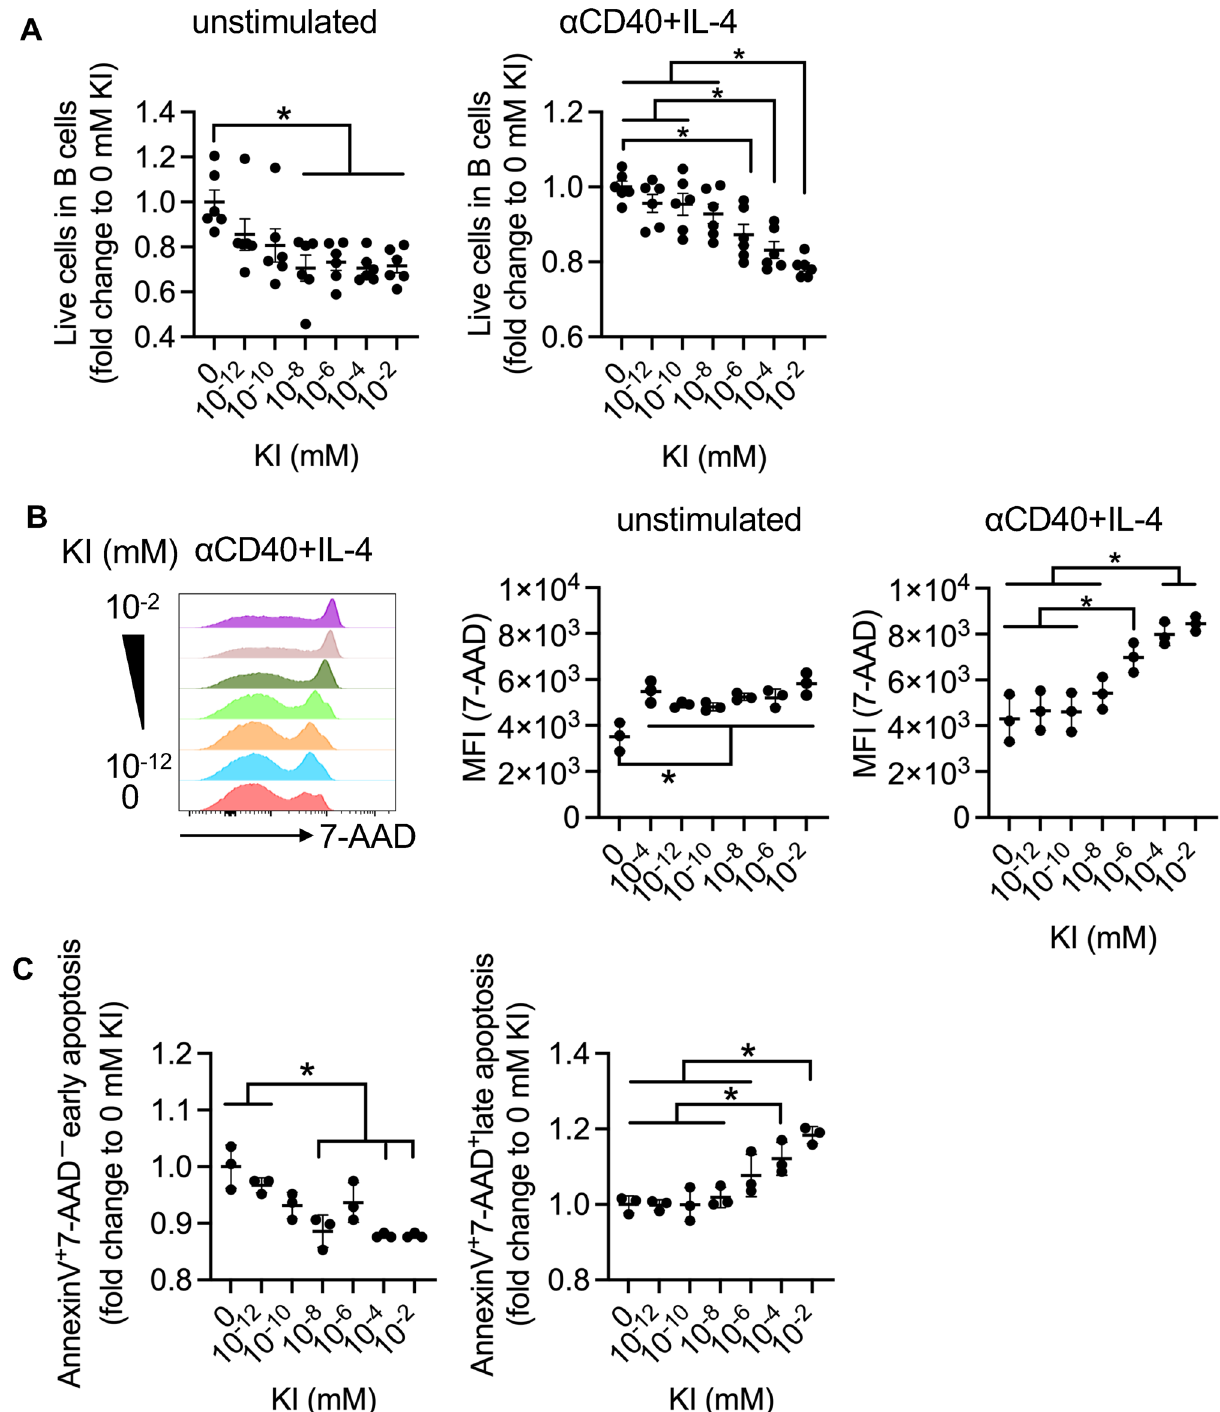
Figure 4. A high dose of iodide promotes activated B cell death via non-apoptotic cell death. Splenic B cells collected from C57BL/6 J mice were cultured with anti-CD40 antibody, IL-4, and serially diluted KI for three days. ( A ) The relative survival rate of B cells (compared to that of untreated cells). The data were pooled from two independent experiments and are shown as mean ± SEM ( n = 6 for each point). ( B ) Median fluorescence intensity of 7-AAD. Representative data from two independent experiments are shown as the mean ± SD ( n = 3 for each point). ( C ) Annexin V + 7-AAD - early apoptotic B cells (left) and annexin V + 7-AAD + late apoptotic B cells (right). Representative data from two independent experiments are shown as the mean ± SD ( n = 3 for each point). One-way ANOVA with Tukey’s multiple comparison test. n.s.: not significant, * p < 0.05, ** p < 0.01. IL, interleukim; KI, potassium